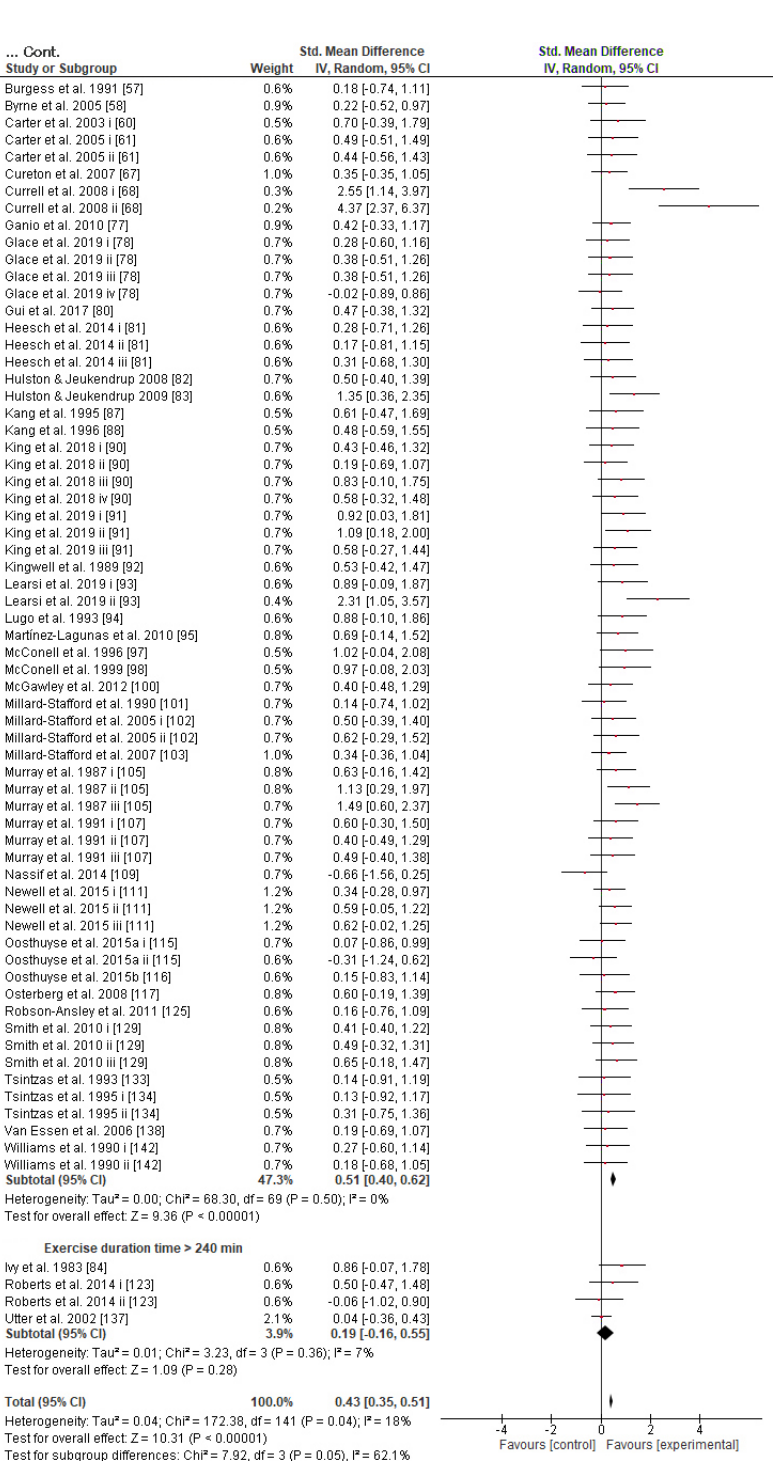
Figure 4. Forest plot shows the effects (red square symbol) of experimental carbohydrate supplementation as compared to a control on exercise outcome for 142 interventions [47–142]. Subgroup analyses show the results with regards to the exercise task in four exercise duration time groups (45 min ≤ T ≤ 60 min, 60 min < T ≤ 120 min, 120 min < T ≤ 240 min, T > 240 min). The black diamond symbol at the subgroups and at the bottom of the figure represents the standardized mean difference with the 95% confidence intervals for all interventions following random effects meta-analyses. Studies or trials that provided insufficient data for subgroup classification were not included. Abbreviations: CI, confidence interval; IV, inverse variance; SD, standard deviation; Std, standardized; T, time; i–vi denote different intervention arms (trials) within the same study.